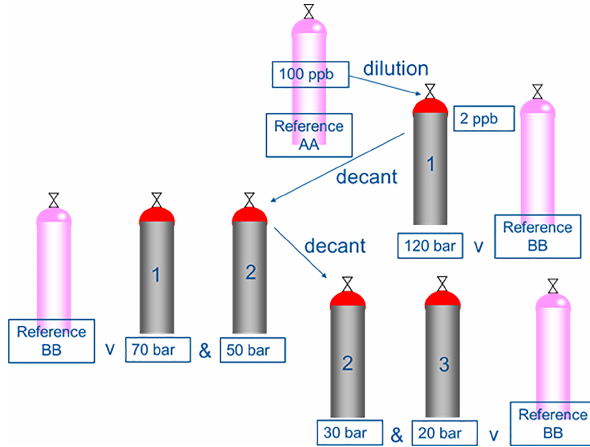
Figure 1. Schematic of the decanting procedure that was per- formed for the monoterpenes using 10L Luxfer cylinders treated with different passivation types (Experis, SPECTRA-SEAL and an in-house treated